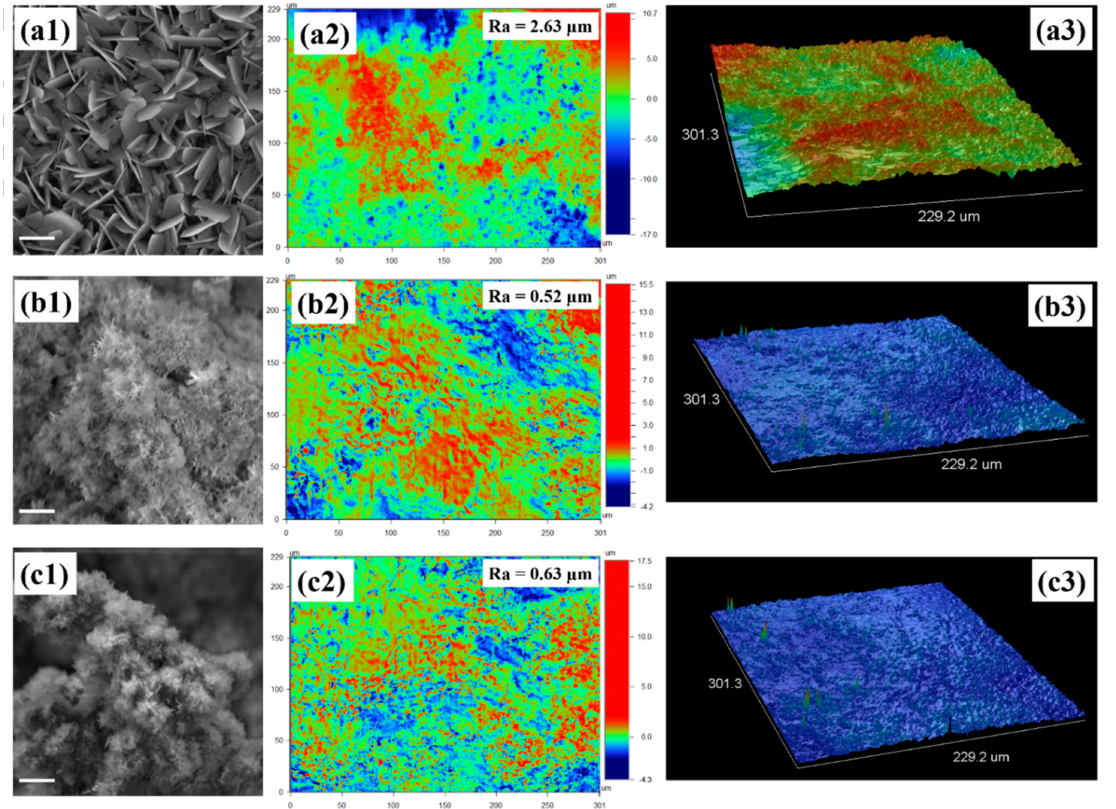
Figure 2. SEM and optical profilometry collected from deposited nHAp and nHAp/MWCNT